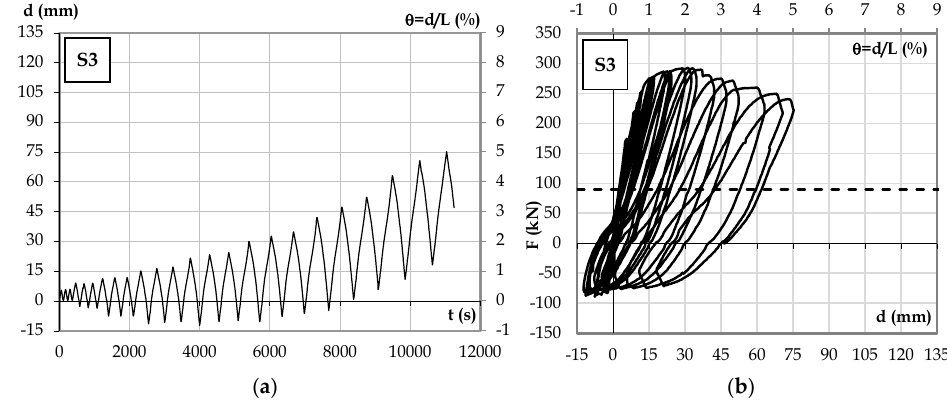
Figure 10. Specimen S3: ( a ) displacement history; ( b ) force-displacement hysteretic diagram.